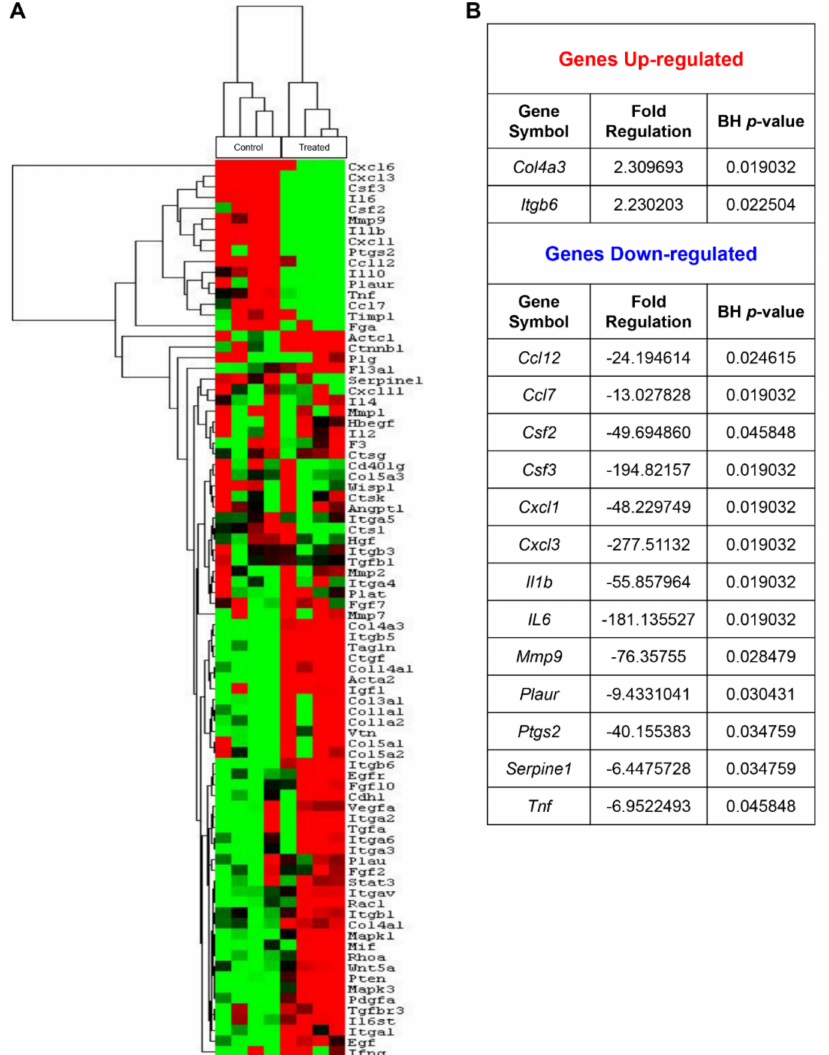
Figure 7. FPF treatment alters gene expression. Expression of 84 wound healing-associated genes in FPF-treated wounds was compared with that in control animals ( A ) Data are presented as a nonsupervised hierarchical clustering of genes with a heat map. ( B ) Individual rat wound healing genes with the most significant positive or negative change are shown for FPF-treated wounds vs. control wounds. N = 4/group. Benjamini-Hochberg adjusted p -value to increase stringency for RT 2 PCR, where p <